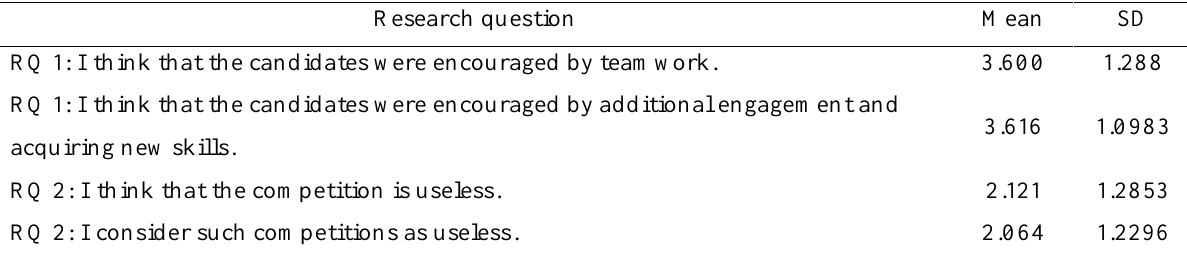
Likert-Type Questions Related to Participation and Attitude Toward Competition Research